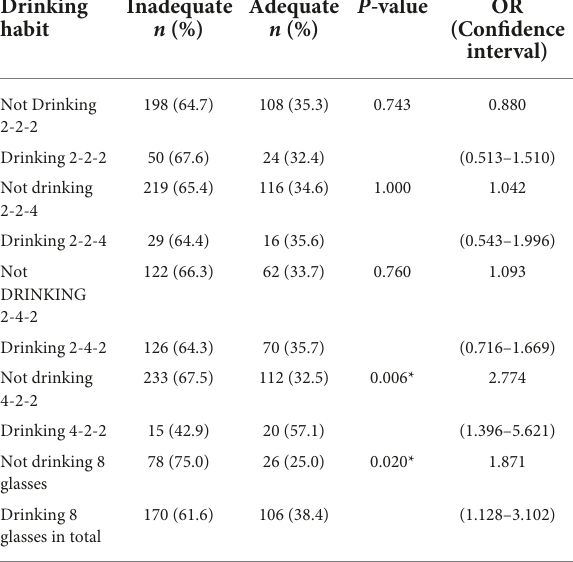
TABLE 4 Pattern of drinking habit and its association with adequate water intake ( n =